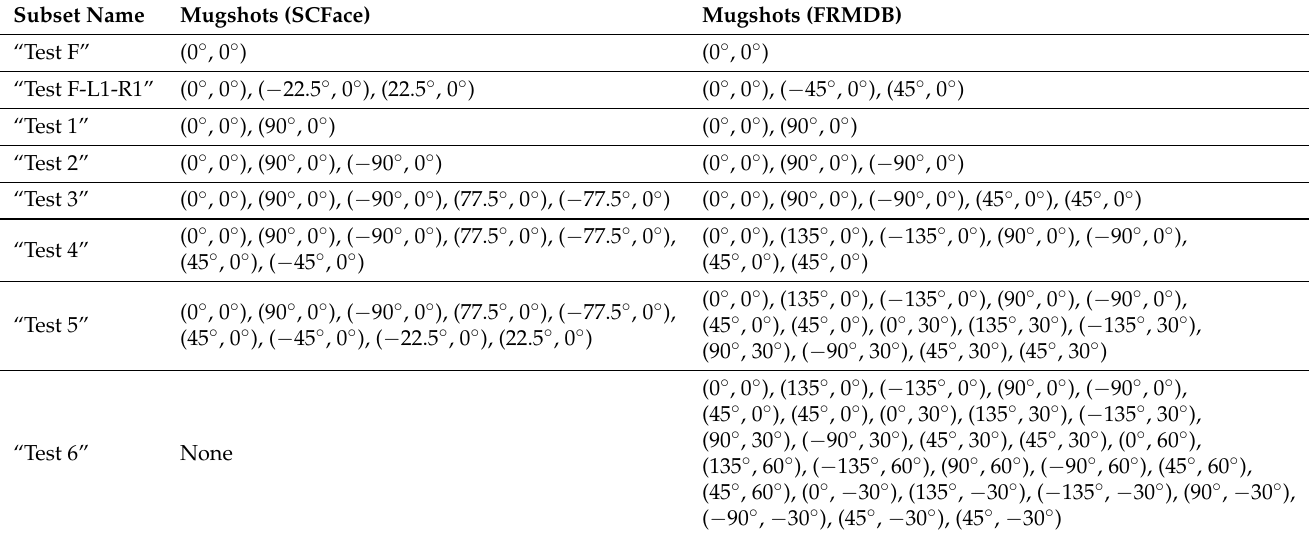
Table 2. The subsets of mugshots from the SCFace database and the FRMDB used as reference images in the tests. The table lists the name we give to each subset and, for each database, the angles from which the included mugshots were taken as a couple ( h , v ) , where h is the angle on the horizontal plane and v is the angle on the vertical